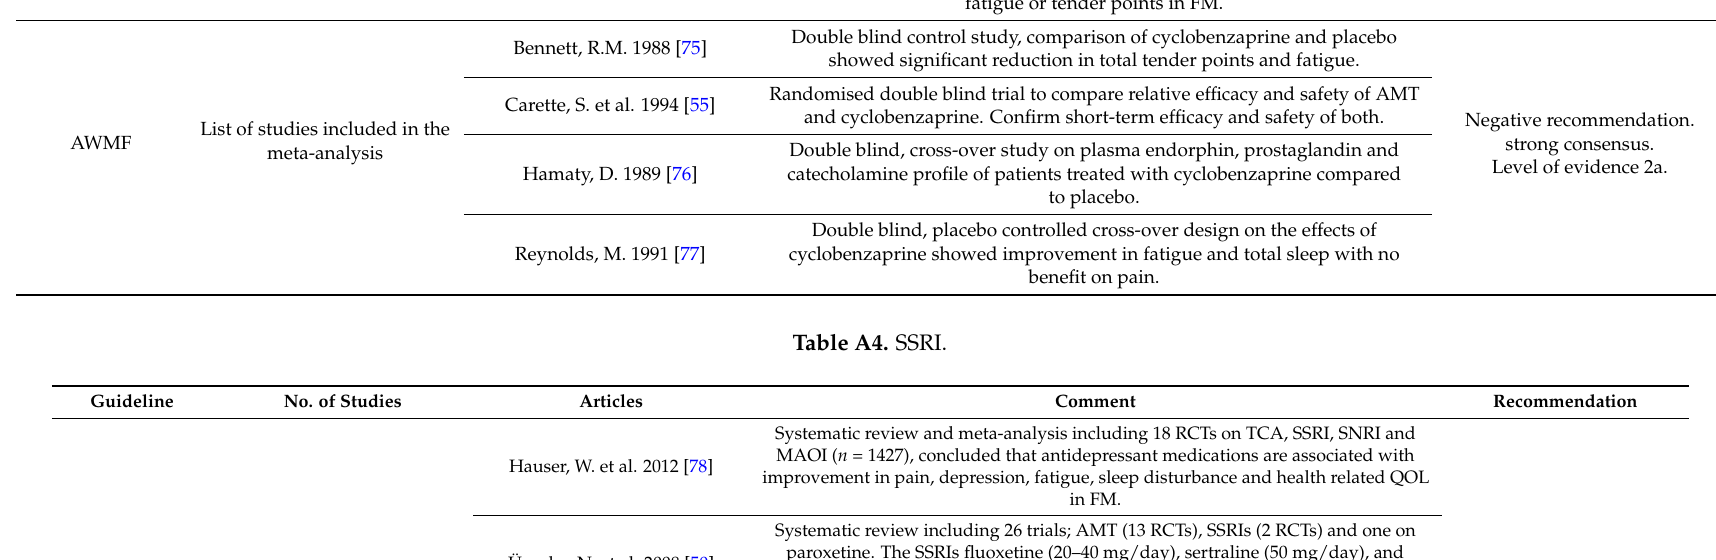
Table A3. Cyclopnezaprine.